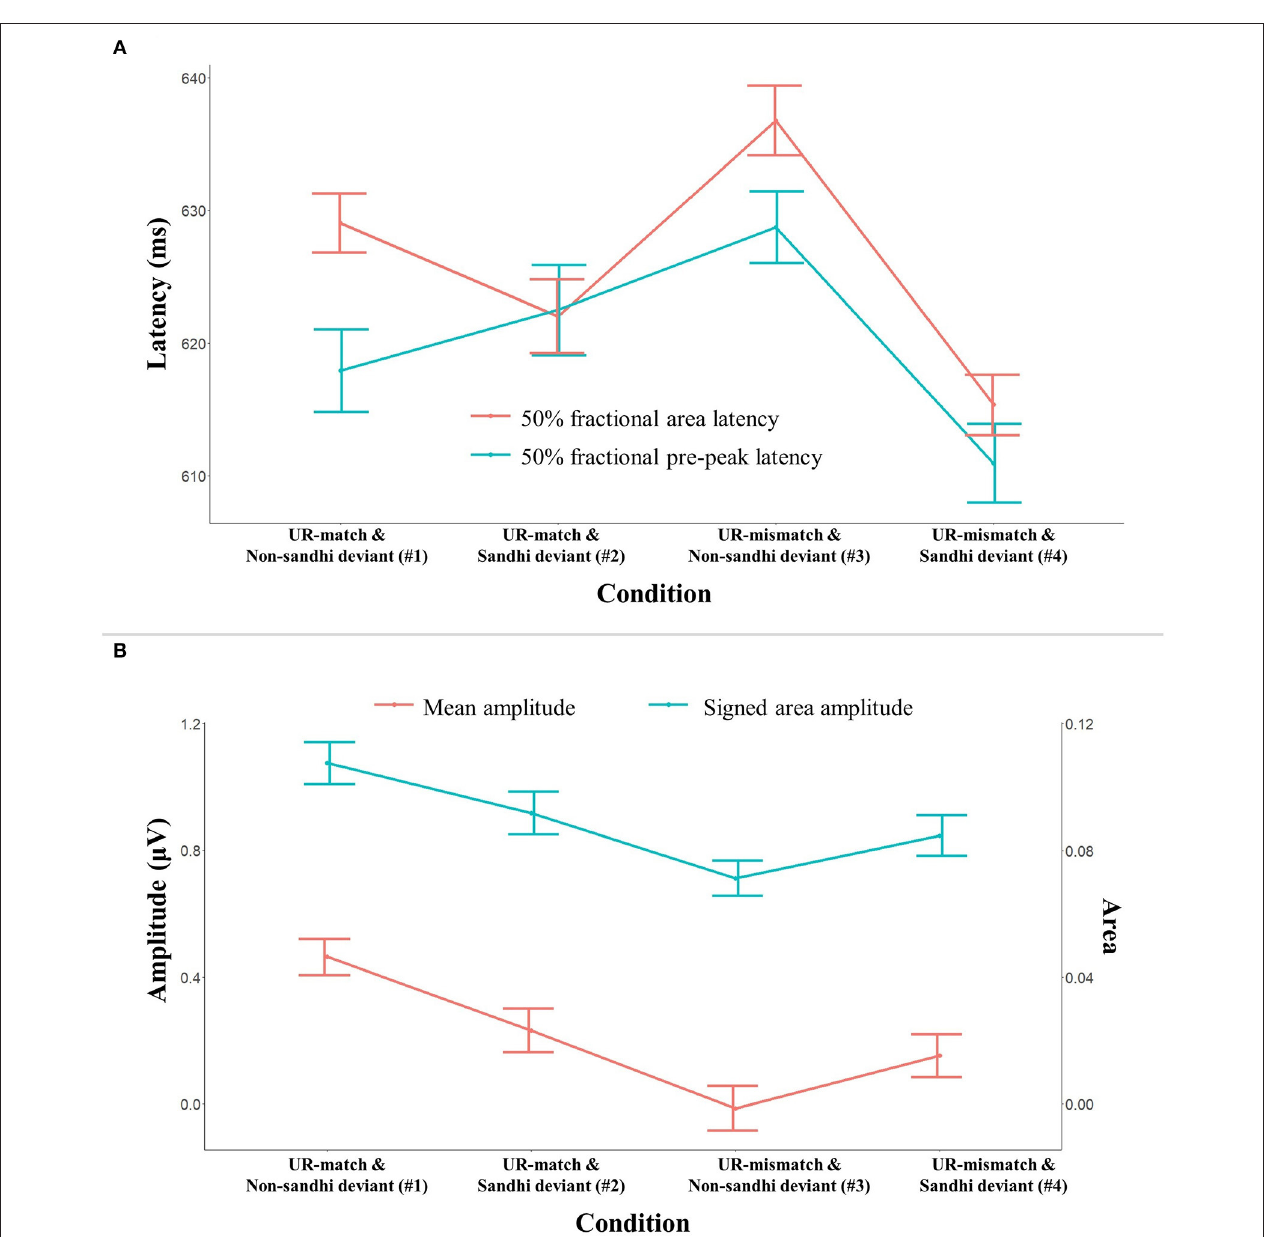
FIGURE 7 | Latency (upper panel) and amplitude (lower panel) measures for the S2 negativity. The error bars indicate 95% confidence interval (95% CI). Panel (A) shows two latency measures (50% fractional area latency, 50% fractional pre-peak latency) as a function of experimental condition. Panel (B) shows two amplitude measures (mean amplitude, signed area amplitude) as a function of experimental